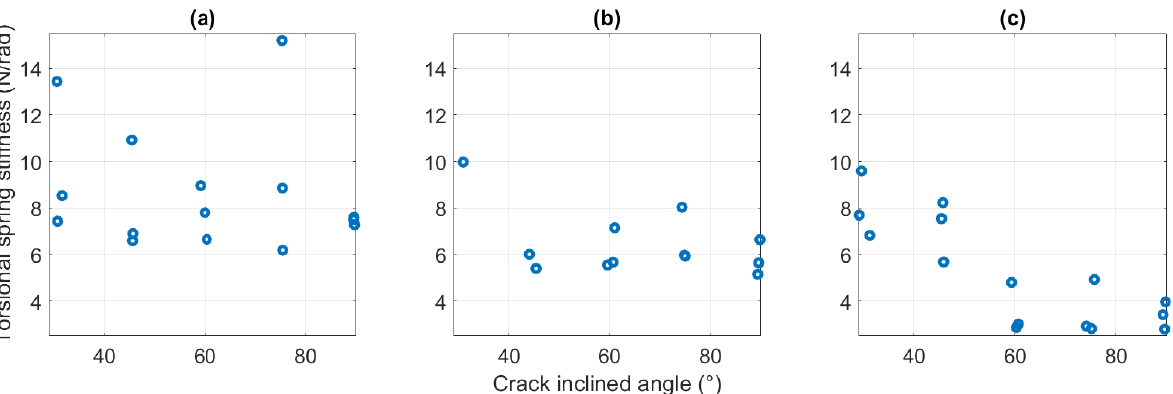
Figure 7. Equivalent torsional spring stiffness for inclined cracks with different angles. ( a ) 1 mm crack length. ( b ) 1.3 mm crack length. ( c ) 1.6 mm crack